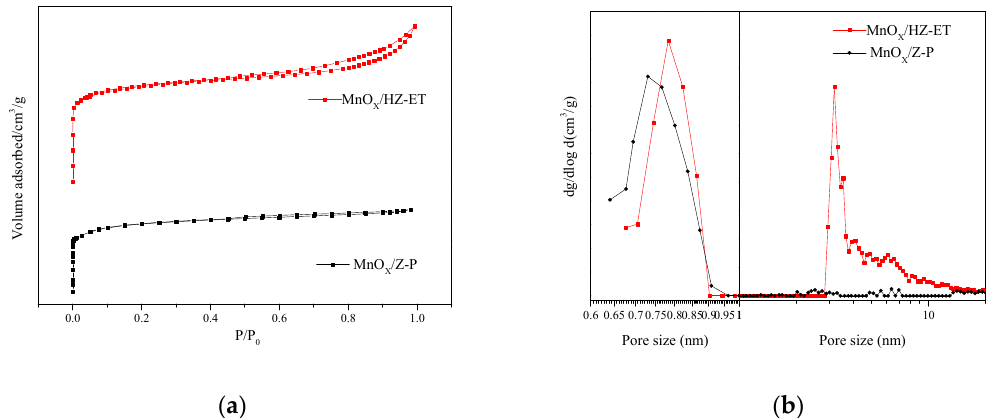
Figure 4. ( a ) N 2 adsorption-desorption isotherms and ( b ) pore size distribution of the catalysts.